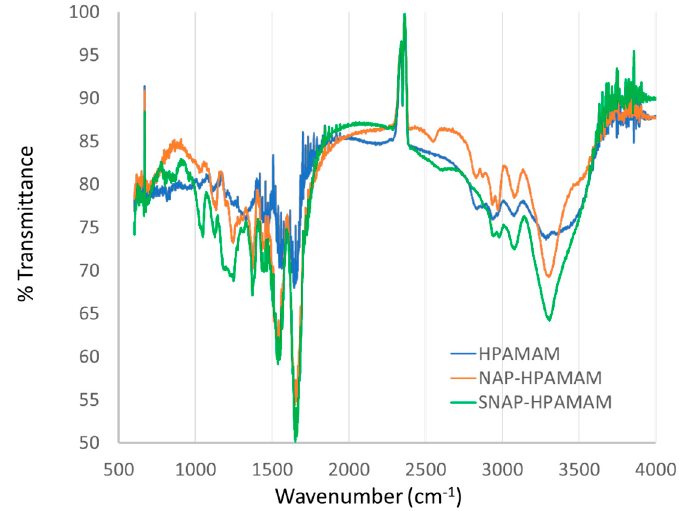
Figure 5. FTIR analysis of HPAMAM (blue), NAP-HPAMAM (orange), and SNAP-HPAMAM (green) compounds, the double spike that appears near 2400 cm − 1 is an instrument artifact and used to align spectra.